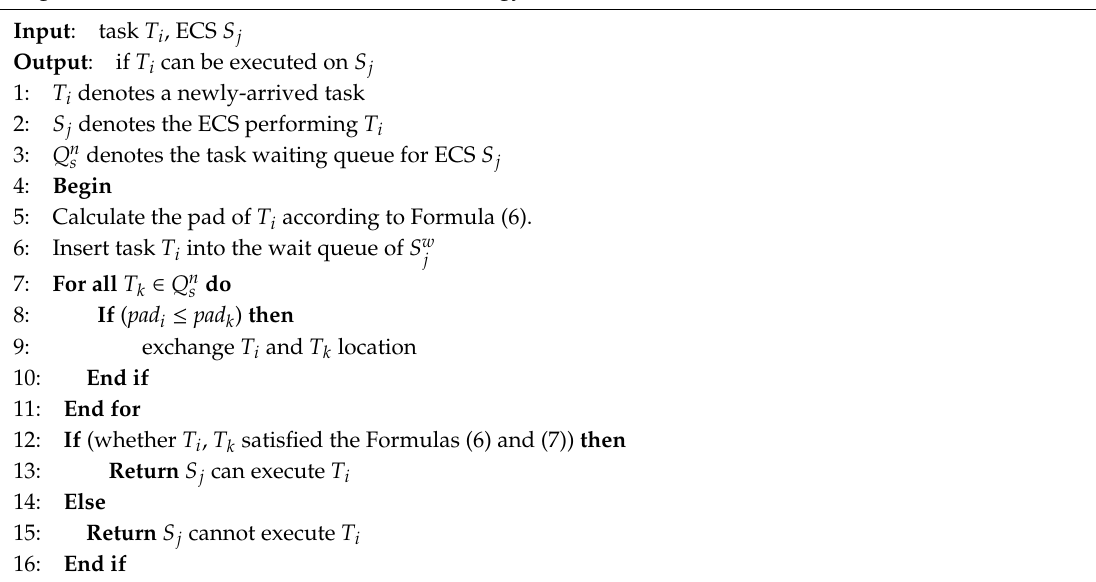
Algorithm 1 ECS Internal Task Execution